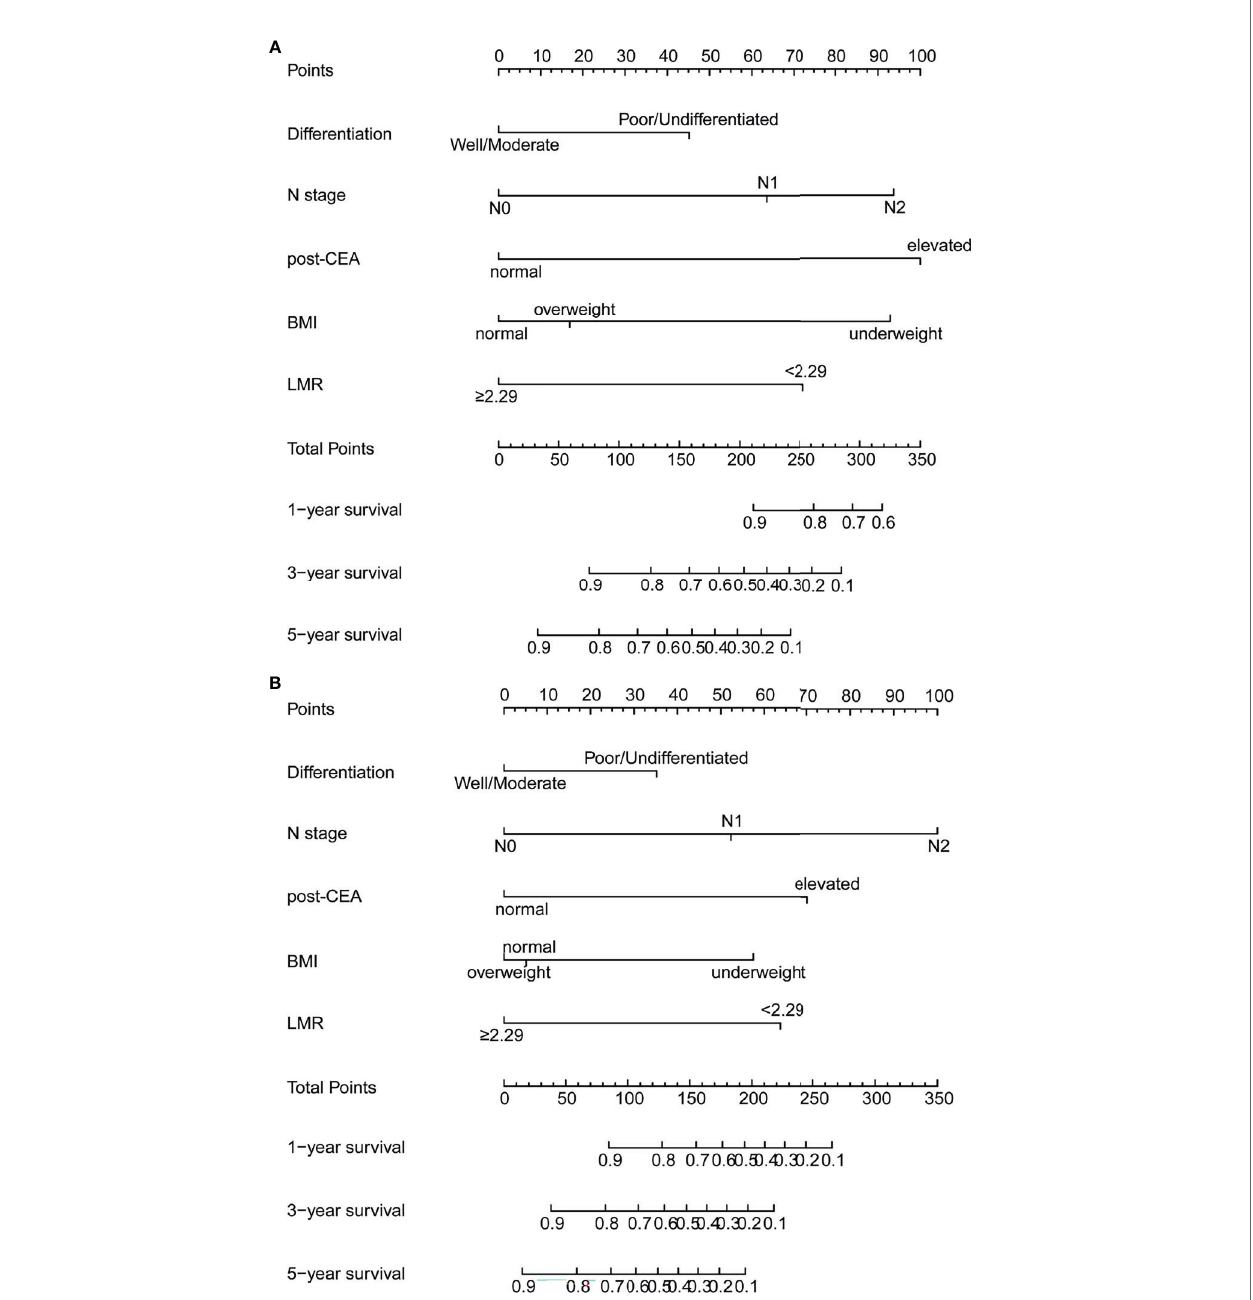
FIGURE 3 | Prognostic nomograms for prediction of the 1-year, 3-year, and 5-year (A) overall survival (OS) and (B) disease-free survival (DFS) of patients with colorectal cancer (CRC). post-CEA, post-operative carcinoembryonic antigen; BMI, body mass index; LMR, lymphocyte-to-monocyte